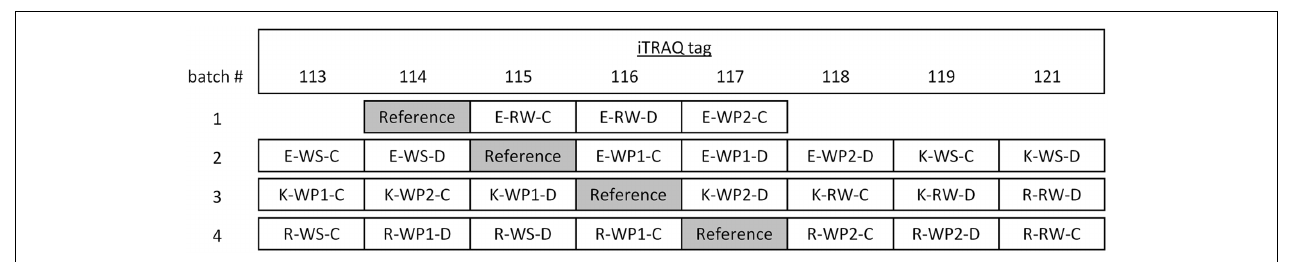
FIGURE 2 | Schematic diagram of iTRAQ labeling for wheat cyclic drought experiment. Abbreviations: E, Excalibur; K, Kukri; R, RAC875; C, well-watered controls; D, cyclic drought-treated samples.